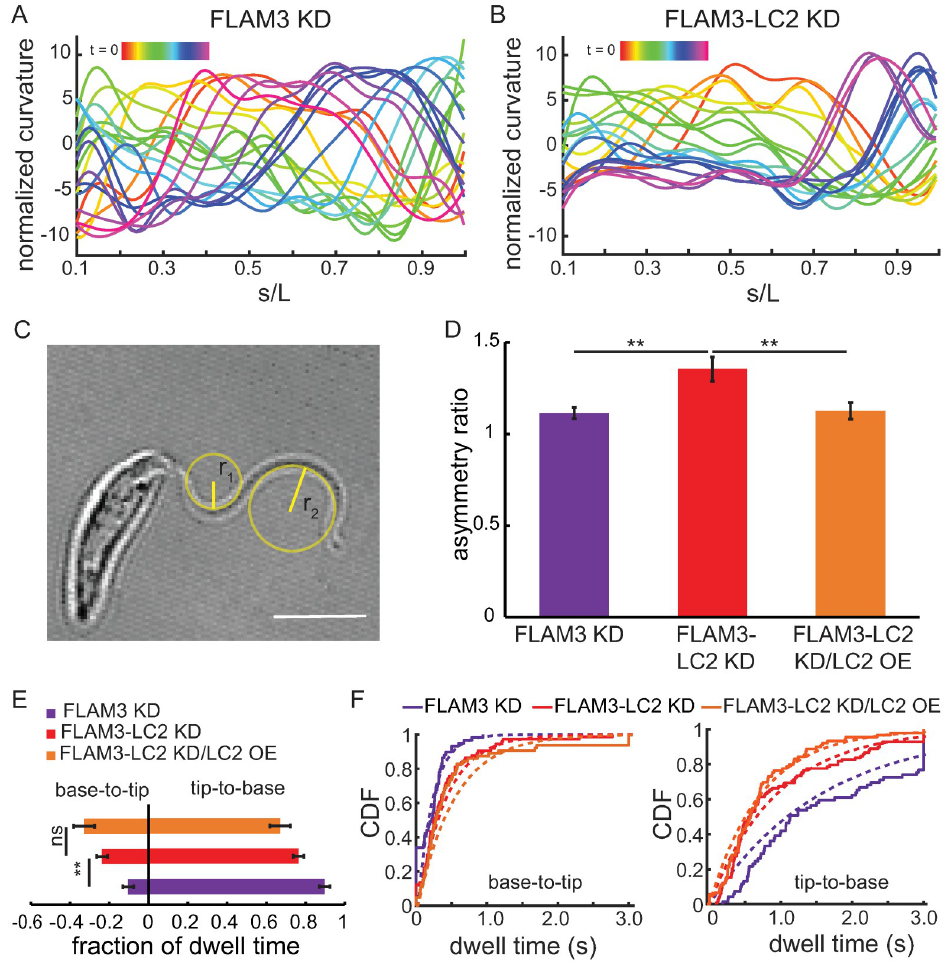
Fig 7. Loss of TbLC2 alters multiple aspects of the ciliary beat waveform. Representative plots of curvature, κ , normalized to the contour length (L) for A . FLAM3 KD and B . FLAM3-LC2 KD cells plotted as a function of s/L, which is the ratio of the arc length along the cilium (s) to the total ciliary length (L), where s/L = 0 is the base and s/ L = 1 is the tip of the cilium. Colors ( red to magenta ) represent the time evolution of ciliary beat shape over one complete period of the oscillation. C . Schematic showing the radii of curvature corresponding to the maximum positive, r 1 , and the maximum negative, r 2 , curvature, where the curvature is 1/the radius of curvature, κ = 1/r, in this frame. We used these radii of curvature to calculate the asymmetry ratio of a ciliary bend during a ciliary beating. This image is a representative frame from a high-speed movie of a FLAM3-LC2 KD cell. Scale bar = 5 μ m. D . Mean maximum curvature asymmetry ratio, AR MC , for FLAM3 KD, FLAM3-LC2 KD, and FLAM3-LC2 KD/LC2 OE cells. N = 15 waveforms from 10–12 different cells in each cell line, the error bars represent the SEM, and �� represents a p - value < 0.005, two-tailed paired t -tests. E . Fraction of time cells dwelled in tip-to-base (positive fraction) and base-to- tip (negative fraction) ciliary beating modes. N = 42, 44, and 33 cells for FLAM3 KD, FLAM3-LC2 KD, and FLAM3-LC2 KD/LC2 OE cells, respectively. �� represents a p -value of < 0.001 and ns a p -value > 0.05, two-tailed paired t -tests. F . Cumulative distribution function (CDF) of individual dwell times for various FLAM3 knockdown cells in base-to-tip ( left ) and tip-to-base ( right ) ciliary beating modes. The fits ( dotted lines ) to exponential functions are shown. Forty-five cells of each strain were analyzed with a total number of n = 59, 75, 65 base-to-tip mode and n = 70, 99, and 90 tip-to-base mode switching events for FLAM3 KD, FLAM3-LC2 KD, and FLAM3-LC2 KD/LC2 OE cells,